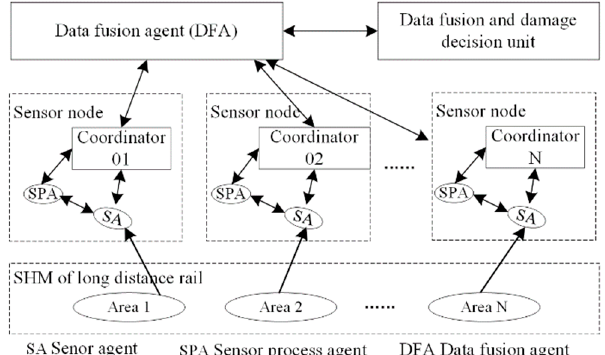
Figure 6. Online monitoring and damage identification of rail defect data by the MAS.